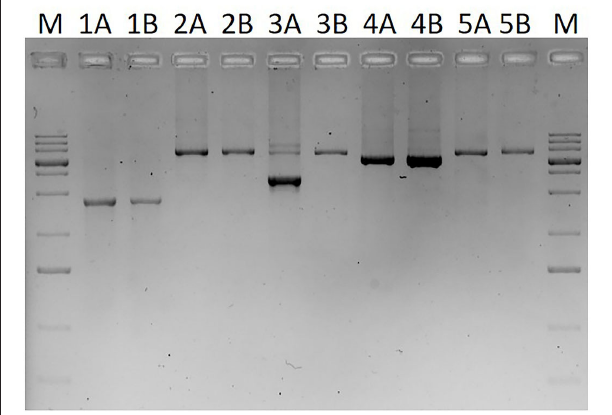
FIGURE 3 | Image of agarose gel (1%) electrophoresis of long-range PCR products covering the whole SERPING1 gene. M: GeneRuler 1kb plus DNA ladder (Thermo Scientific, Waltham, MA, USA). PCR products in lines involve the following exons: lines 1: exons 1–3 (from the binding site of the MLPA probe specific for exon 1), lines 2: exons 3–5, lines 3: exons 5–7, lines 4: exons 7–8, lines 5: exon 8 (plus an extra 1375 bp downstream from the 3’-end of exon 8). Samples marked with A (1A − 5A) are derived from a C1-INH-HAE patient, samples with B (1B − 5B) are from a healthy